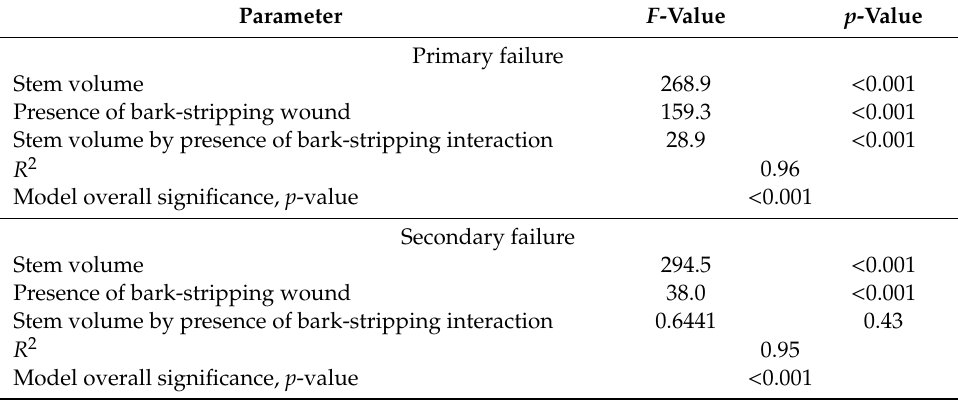
Table 2. Regression between tree stability parameters and stem volume and cervid damage for the damaged